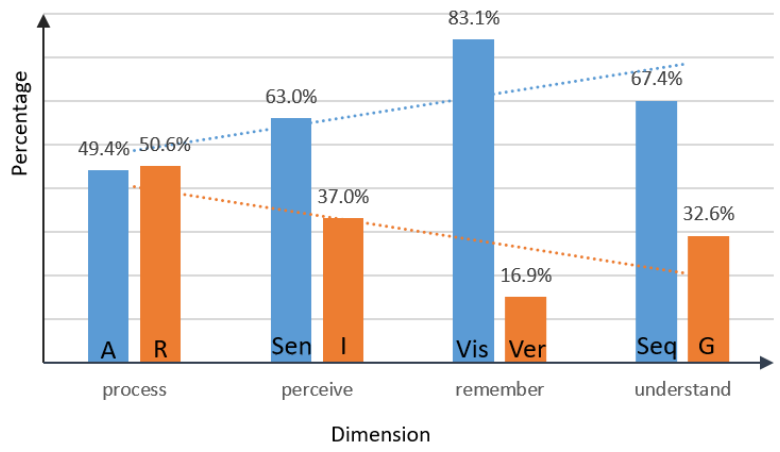
Figure 2. The percentage of responds’ preferred manners for each